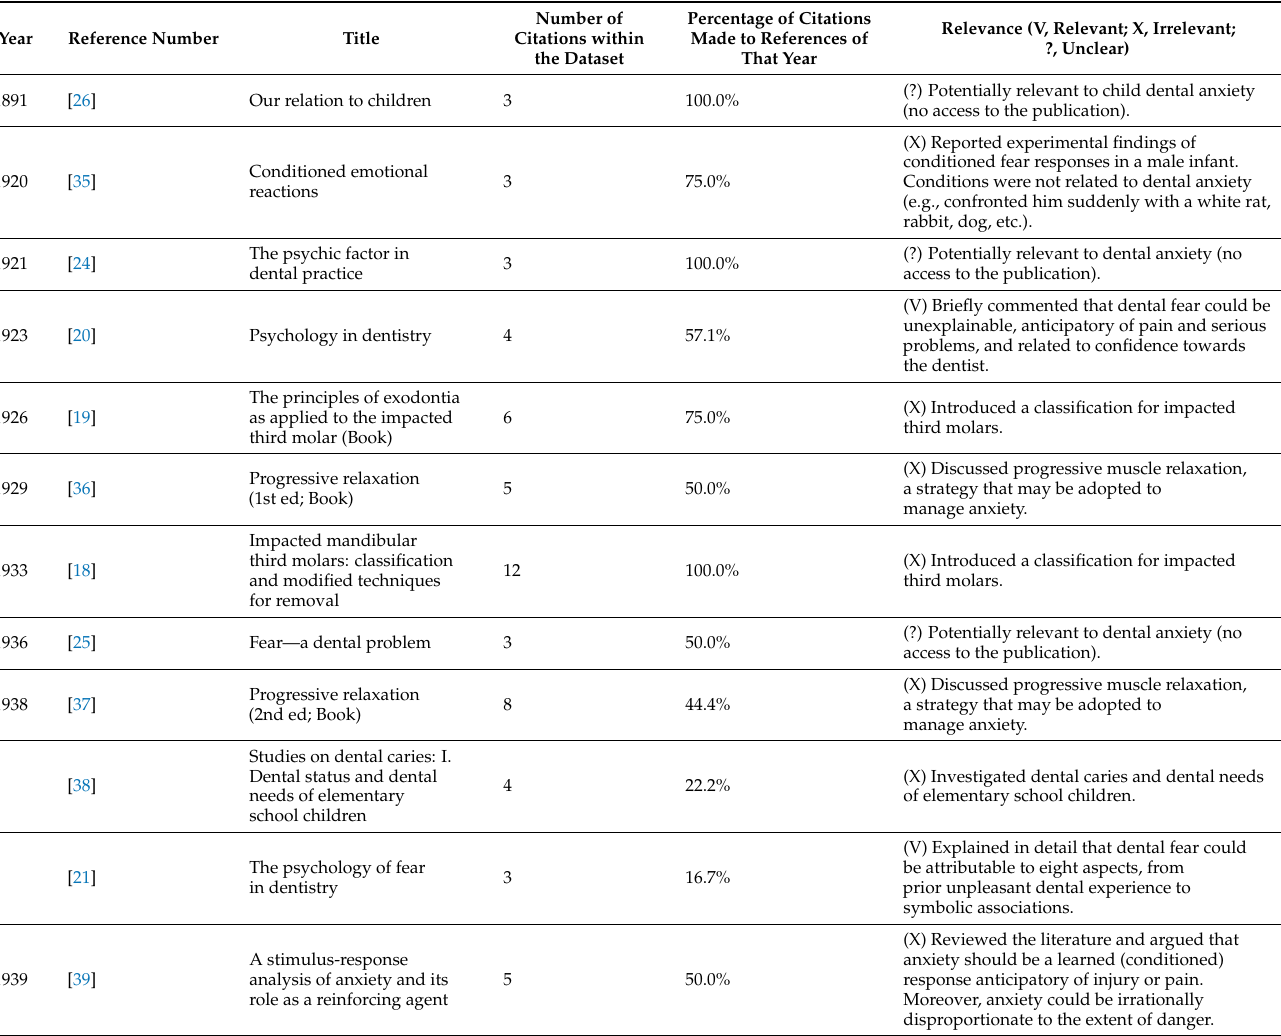
Table 1. Details of potential historical roots of dental anxiety as revealed by the reference publication year spectrogram (RPYS) shown in Figure